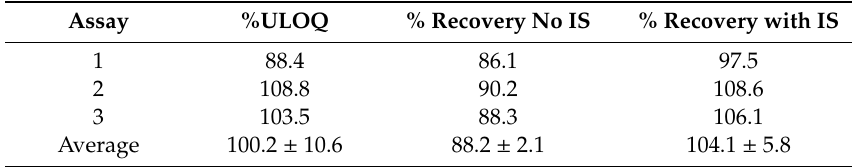
Table A6. α -tocopherol recovery assay.